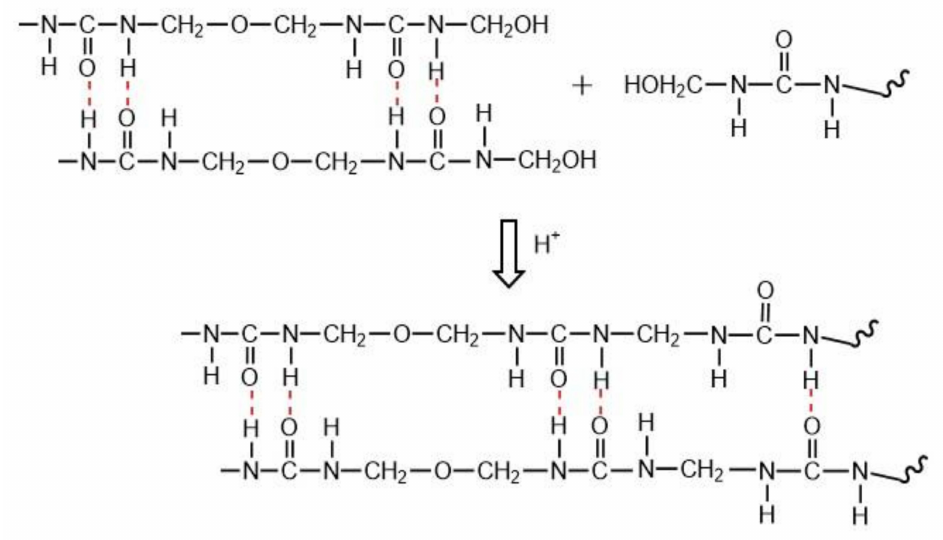
Figure 15. Growth of Crystalline region of UF resin with low molar ratio F/U in the presence of the curing agent (H +